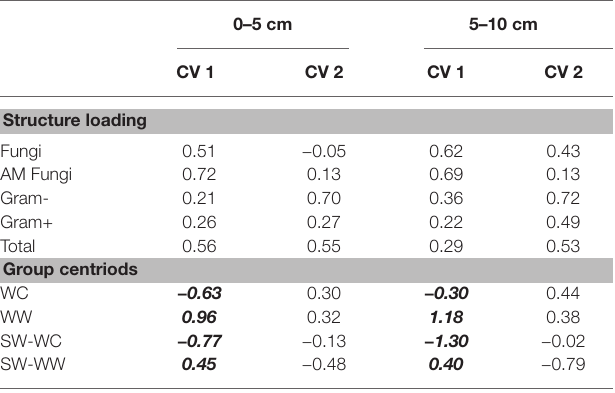
TABLE 2 | Structure matrix (pooled within canonical structure) and biomarker means (group centroid) for the WC-WW-SW cropping sequence at the 0–5 and 5–10 cm depths.